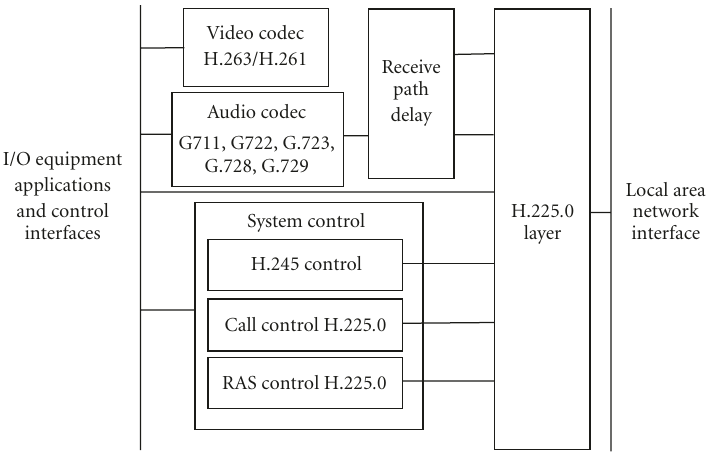
Figure 1: Scope of H.323 terminal equipment